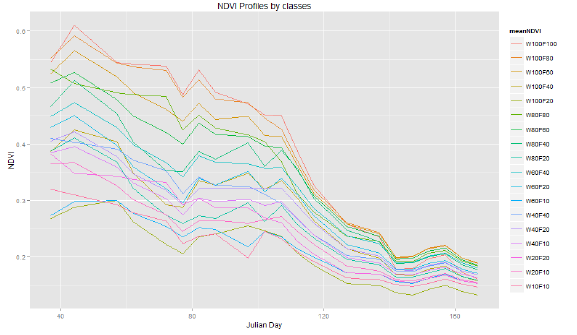
Figure 2. NDVI profiles from by vegetation